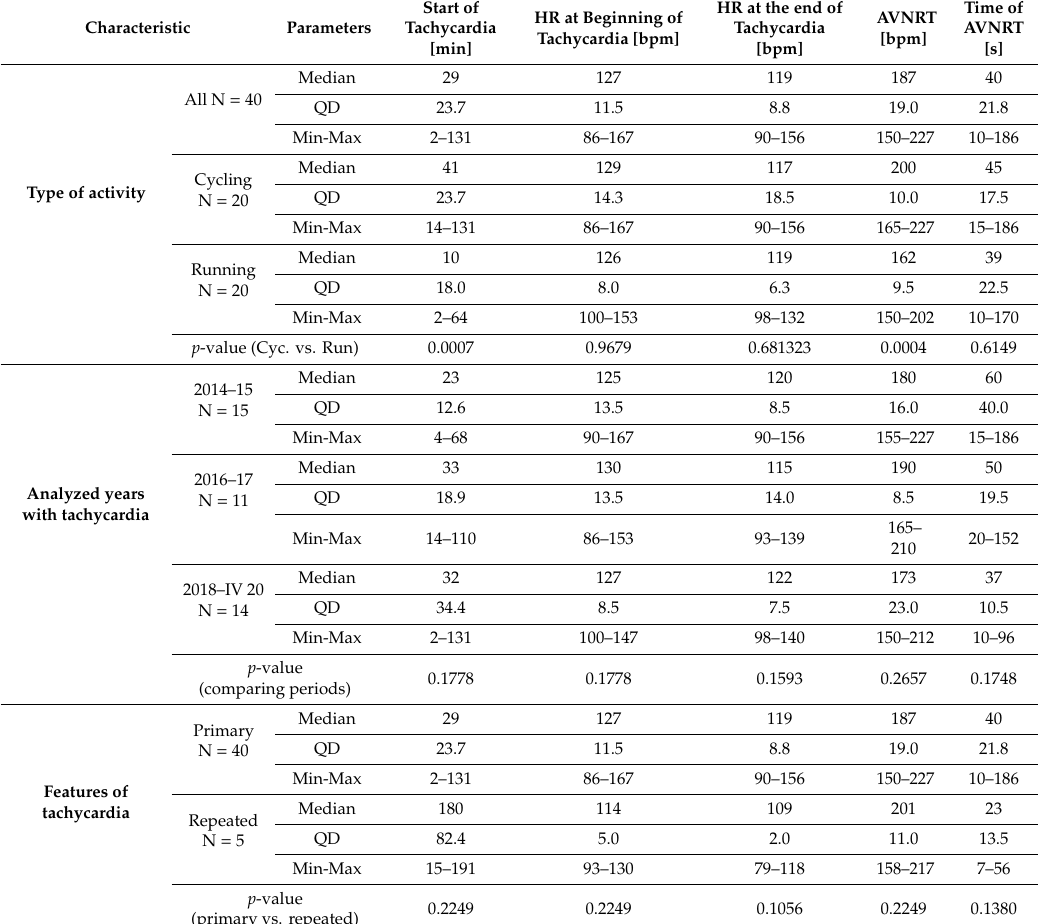
Legend: Cyc. vs. Run—Cycling versus Running, QD—Quartile